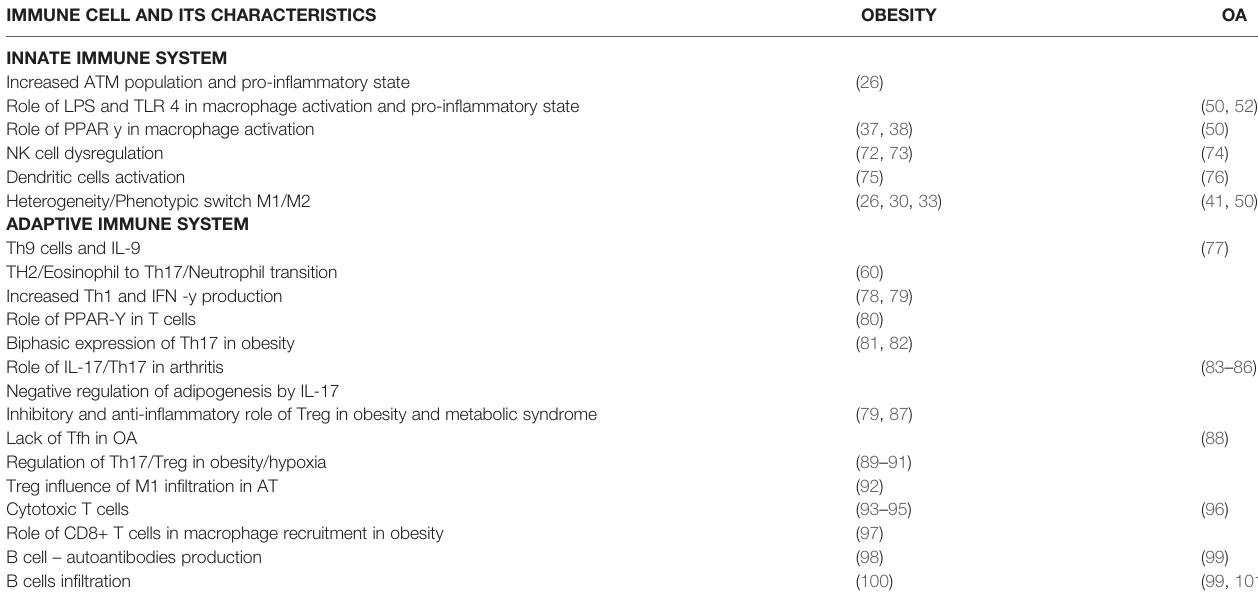
TABLE 1 | Details cellular functions of the innate and adaptive immune cells on the review are mentioned in detail along with the references. IMMUNE CELL AND ITS